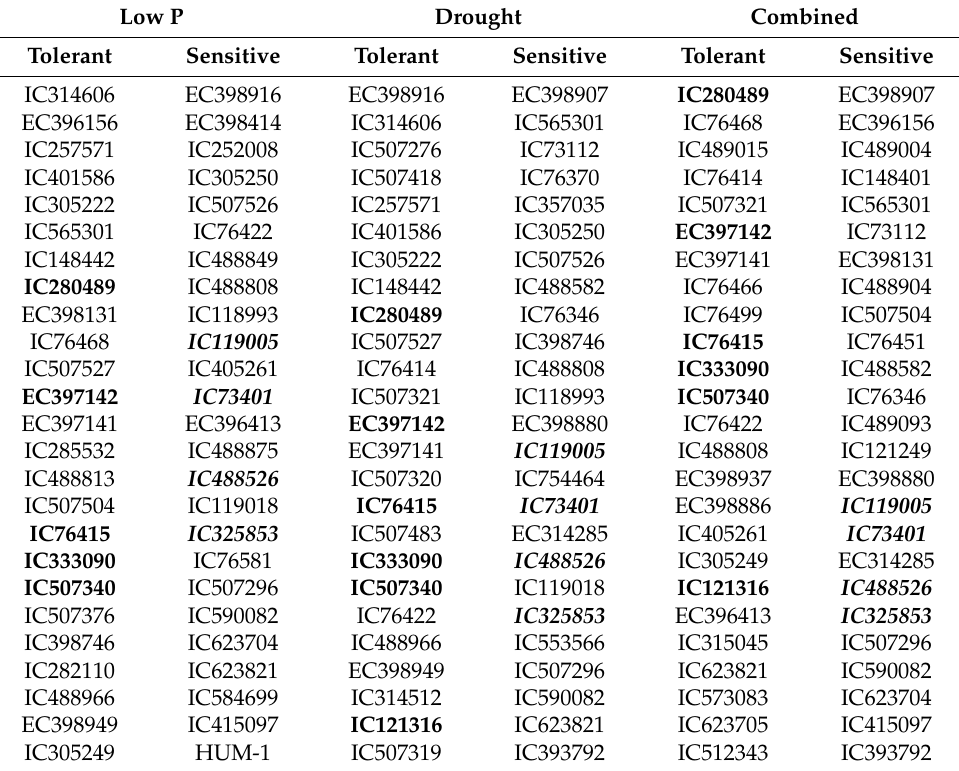
Table 1. Selection of tolerant and sensitive mungbean accessions (25 each) based on their response to different stresses viz ., low P, drought, and combined (low P and drought). These accessions were identified on the basis of principal component analysis ranking using loading score from relative values under treated conditions. The ranking values are presented in Table S3. Low P Drought Combined Tolerant Sensitive Tolerant Sensitive